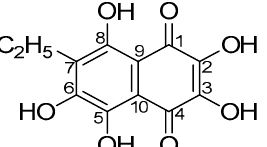
Figure 1. Chemical structure of echinochrome A (7-ethyl-2,3,5,6,8-pentahydroxy-1,4-naphthoquinone, Ech A).